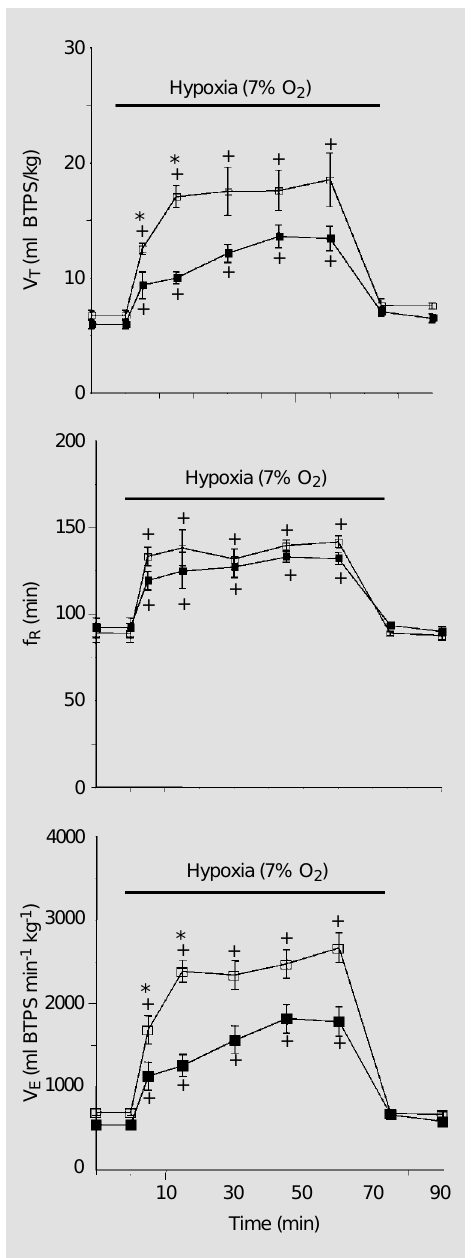
Figure 2 - Effects of hypoxia on tidal volume (V T ), respi- ratory frequency (f R ) and pulmonary ventilation (V E ) of control rats (filled squares) (N = 16) and LC-lesioned rats (open squares) (N = 7). Values are reported as means ± SEM. The hypoxia-induced hyperventilation was higher in LC-lesioned rats. + Significant increase (P<0.05) in V T , f R and V E after hypoxia compared to normoxia. *Significant increase in V T and V E of LC- lesioned rats compared to control group. BTPS, Body temperature, pressure, saturated with water vapor.